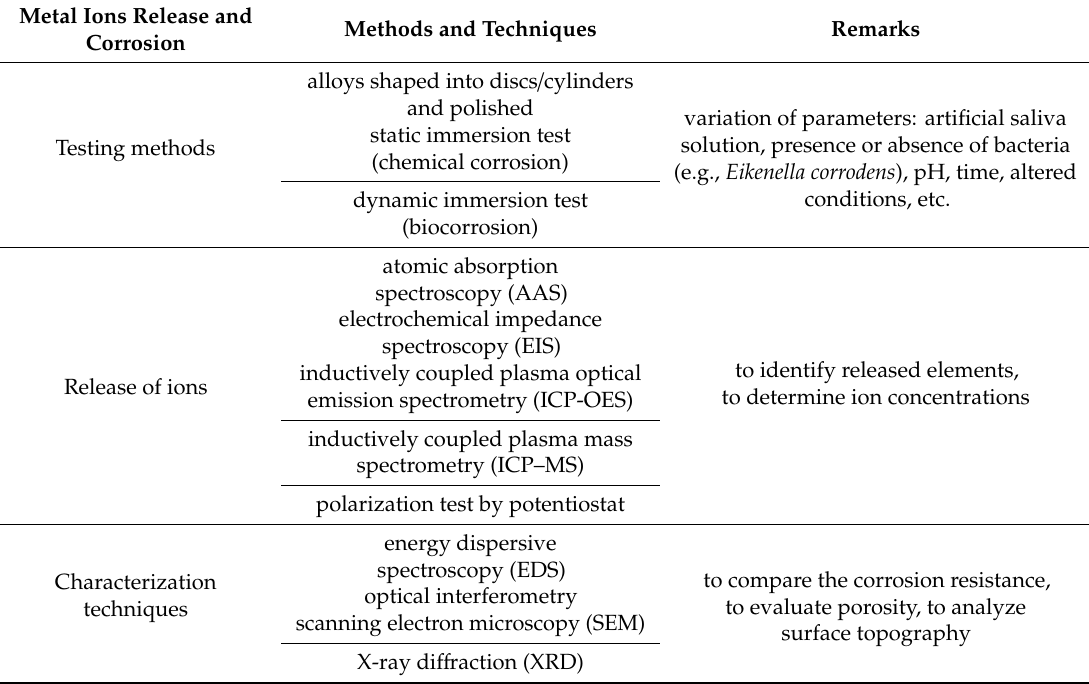
Table 2. Methods and techniques to explore the release of metal ions and corrosion.